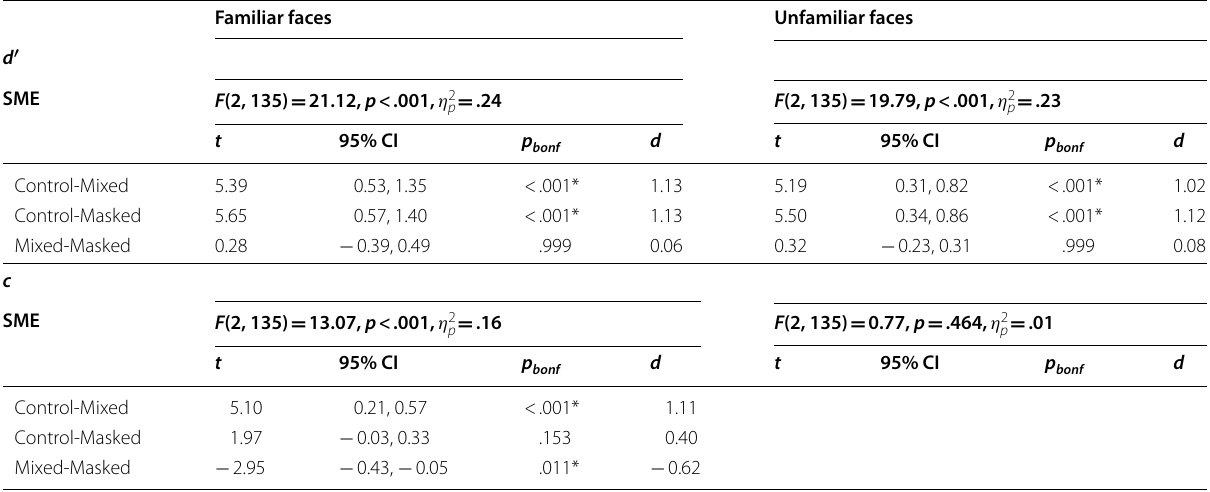
Table 5 Simple main effects (SME) analyses for the effect of mask condition on face familiarity, for measures of human performance ( d ′ , c ) on the